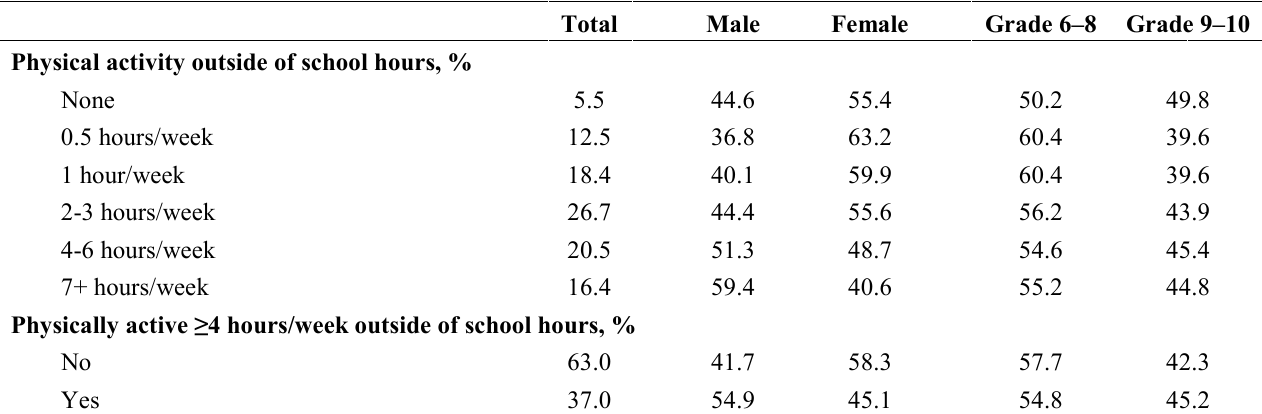
Table 2. Description of physical activity by gender and grade (n =